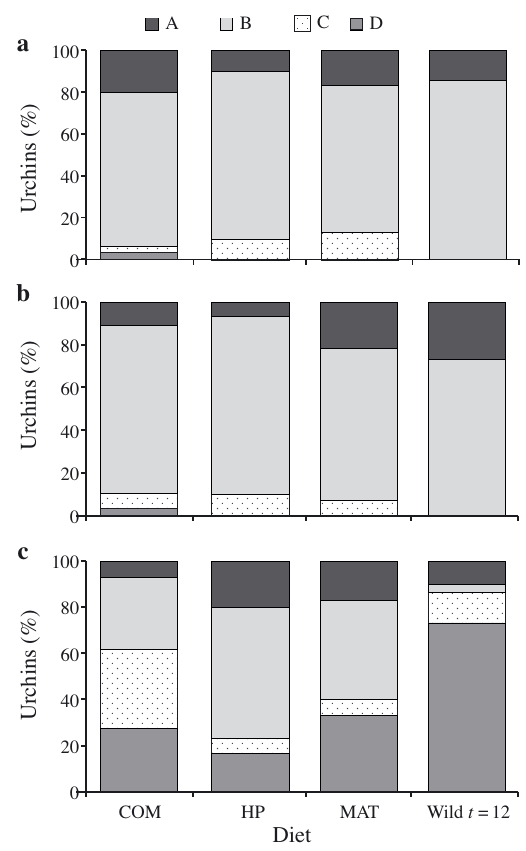
Fig. 5. Expt 2: percentage of purple urchins with A-, B-, C- or D-grade gonads from 3 urchin barrens in Port Phillip Bay, Vic- toria, fed 3 pellet diets for 12 wk and urchins from the wild (Wild t = 12). The pellet diets were a commercially available feed (COM), a high-protein feed (HP) and a feed that had the same protein and lipid levels as the COM diet but was made using different ingredients (MAT). Data are from (a) Barren 1, (b) Barren 2 and (c) Barren 3. The grading was ordinal, with A as the highest grade and D the lowest